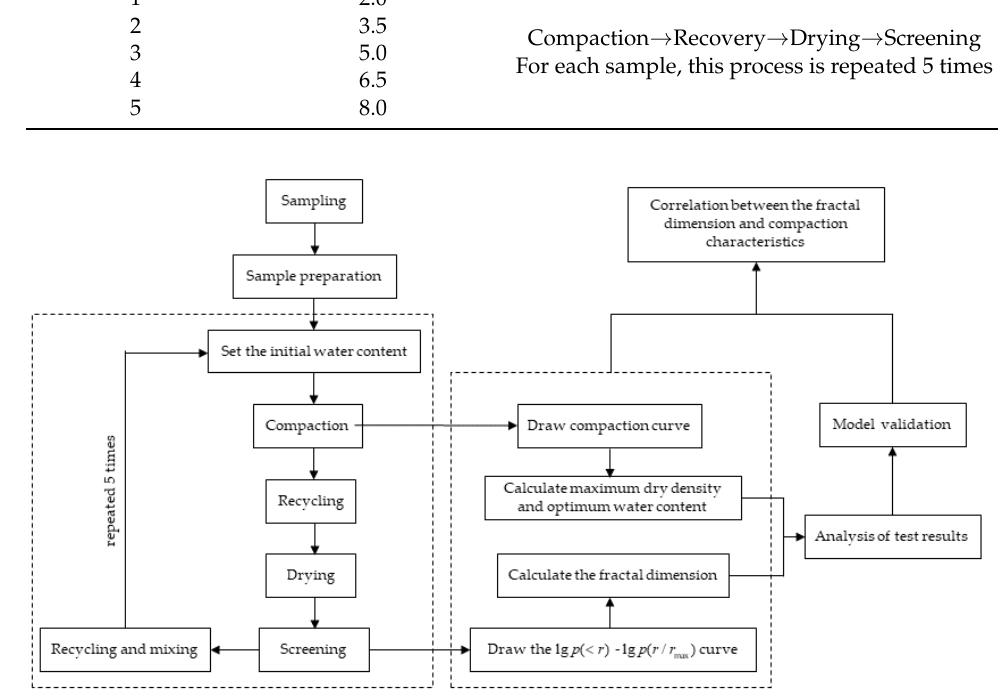
Table 3. Experimental scheme for repeated compaction characteristics of graded crushed stone. Sample No.